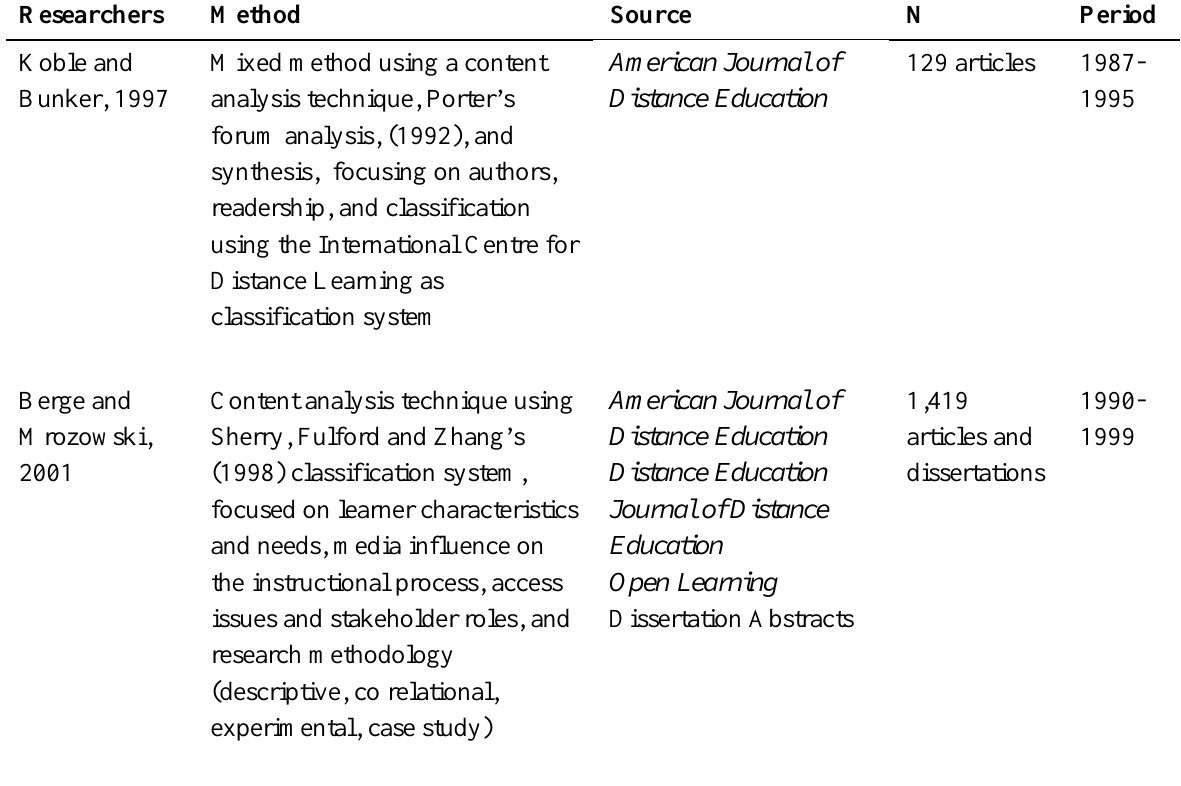
revious Distance Education Synthesis